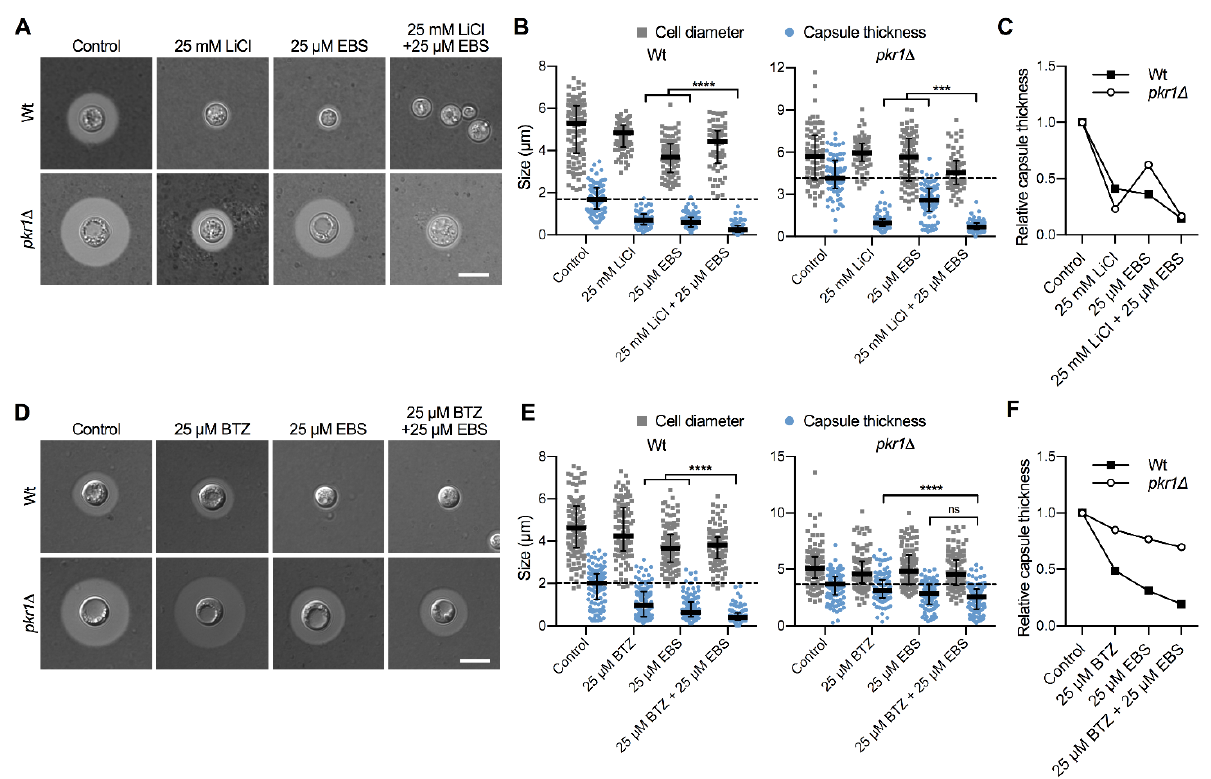
FIGURE 8: The lithium-mimetic drug ebselen inhibits capsule formation, and its activity is potentiated by combination with lithium or bortezomib. (A) DIC microscopy images of the C. neoformans H99S wild type and the pkr1 D mutant grown in CIM (control) or CIM supple- mented with the indicated concentrations of LiCl and/or ebselen for 48 h and stained with India ink to visualize capsule. EBS, ebselen. Scale bar, 5 µm. (B) Quantification of cell diameter and capsule thickness for cells from panel A. The experiment was performed twice, and at least 64 cells were analyzed per strain and condition. Grey squares and blue circles indicate individual data points from both experiments, and the black bar indicates the median – interquartile range. The dotted black lines indicate the median capsule sizes of the Wt or pkr1 D mutant grown under control conditions. *** P < 0.001, and **** P < 0.0001 by t -test. (C) Relative capsule thickness data from panel B. Results were plotted relative to the untreated controls. Note that capsule formation by the pkr1 D mutant is less affected by EBS but more strongly reduced by LiCl compared to the Wt. (D) DIC microscopy images of the C. neoformans H99S wild type and the pkr1 D mutant grown in CIM (control) or CIM supplemented with the indicated concentrations of bortezomib and/or ebselen for 48 h and stained with India ink to visualize capsule. BTZ, bortezomib; EBS, ebselen. Scale bar, 5 µm. (E) Quantification of cell diameter and capsule thickness for cells from panel D. The experiment was performed twice, and at least 100 cells were analyzed per strain and condition. Small grey squares and blue circles indicate individual data points from both experiments, and the black bar indicates the median – interquartile range. The dotted black lines indicate the median capsule sizes of the Wt or pkr1 D mutant grown under control conditions. ns, not significant. **** P < 0.0001 by t -test. (F) Relative capsule thickness data from panel E. Results were plotted relative to the untreated controls. Note that capsule formation by the pkr1 D mutant is less affected by BTZ and EBS compared to the